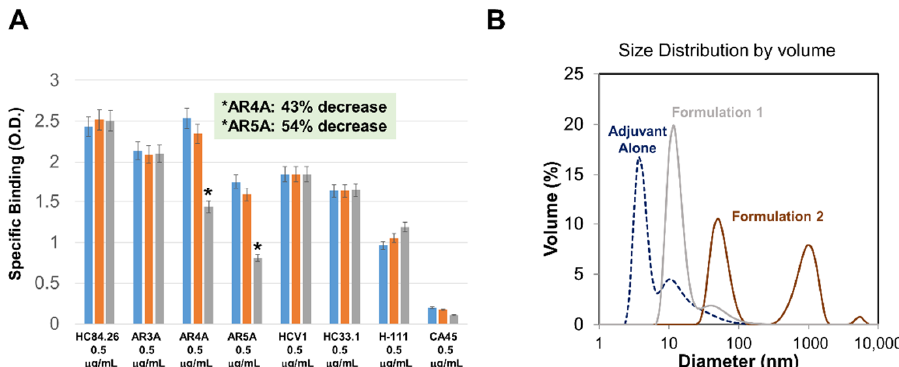
Figure 10. ( A ). Stability analysis of purified mbE1E2 based on temperature-dependent binding to mAbs. Samples were incubated at 25 °C (blue), 37 °C (orange), or 56 °C (gray) for one hour prior to the experiment. ( B ). DLS analysis of mbE1E2 formulated with an adjuvant using two different storage regimens. The size distribution by volume of the adjuvant alone (blue dotted lines) and the two formulations (tan and brown solid lines) is shown.